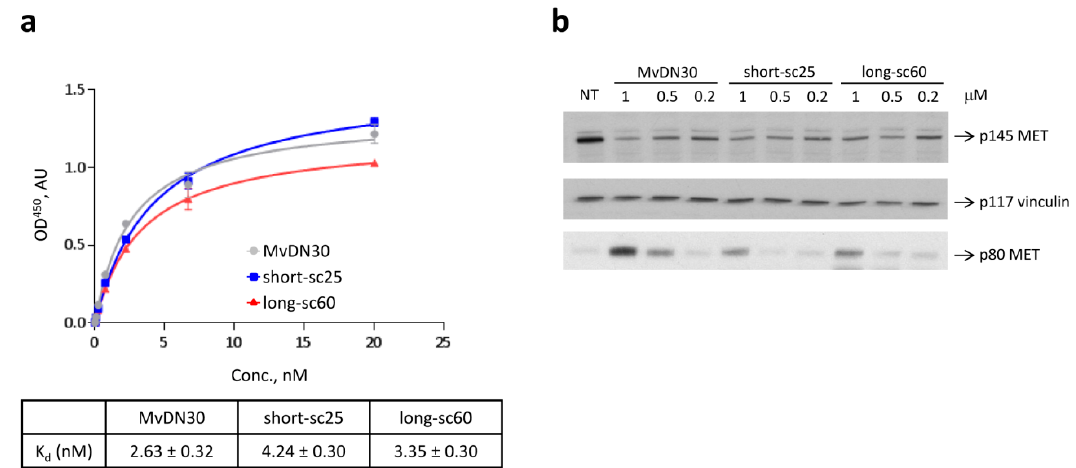
Figure 2. Single-chain Fabs maintain the ability to bind MET with high affinity and induce receptor shedding. ( a ) ELISA binding analysis of the interaction between MET and the single-chain Fabs. The extracellular region of MET fused to the Fc portion of a human IgG (MET-Fc chimera) was immobilized in solid phase and exposed to increasing concentrations of single-chain Fabs in liquid phase. MvDN30 was included in the assay as reference. Each point is the mean of triplicate values; bars represent standard deviation. OD 450 : optical density at 450 nm. AU: arbitrary units. ( b ) Immunoblotting analysis of cell lysates (top panels) and cell culture supernatants (bottom panel) from A549 cells treated for 48 h with the indicated concentrations of the single-chain Fabs; MvDN30 was included in the assay as reference. MET receptor and MET ectodomain levels were detected using anti-MET antibodies that bind epitopes located in the C-terminal tail or in the extracellular domain of the molecule, respectively. Vinculin (p117) was used as loading control. p145 MET: MET receptor β chain; p80 MET: MET ectodomain; NT: non-treated cells. Data reported in the figure are representative of at least two independent experiments.